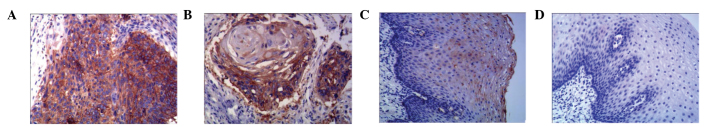
A disintegrin and metalloproteinase 17 protein in esophageal squamous cell carcinoma and adjacent tissues stained using streptavidin peroxidase conjugated immunohistochemistry (magnification, ×100). (A) Squamous cell carcinoma (+++); (B) squamous cell carcinoma (++); (C) adjacent tissues (+); (D) adjacent tissues (−).